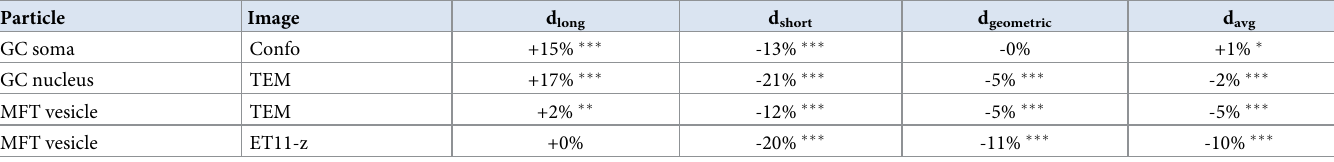
Table 6. 2D diameter measures compared to d area